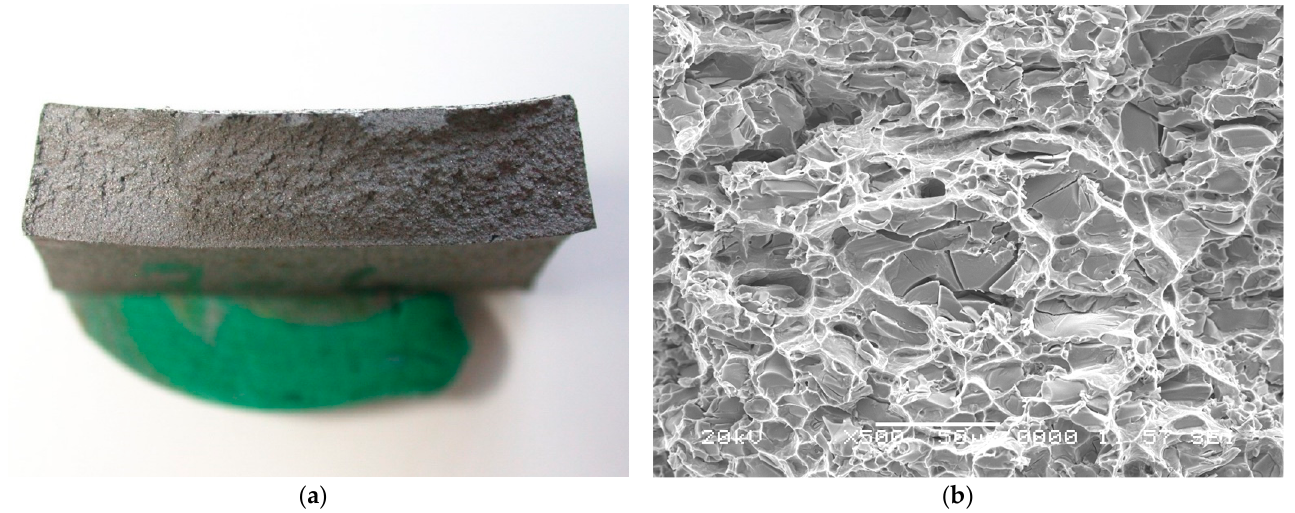
Figure 14. ( a ) Photography of the fracture; ( b ) SEM micrograph of a dimple rupture (the length of the bar in micrograph is 50 µm).